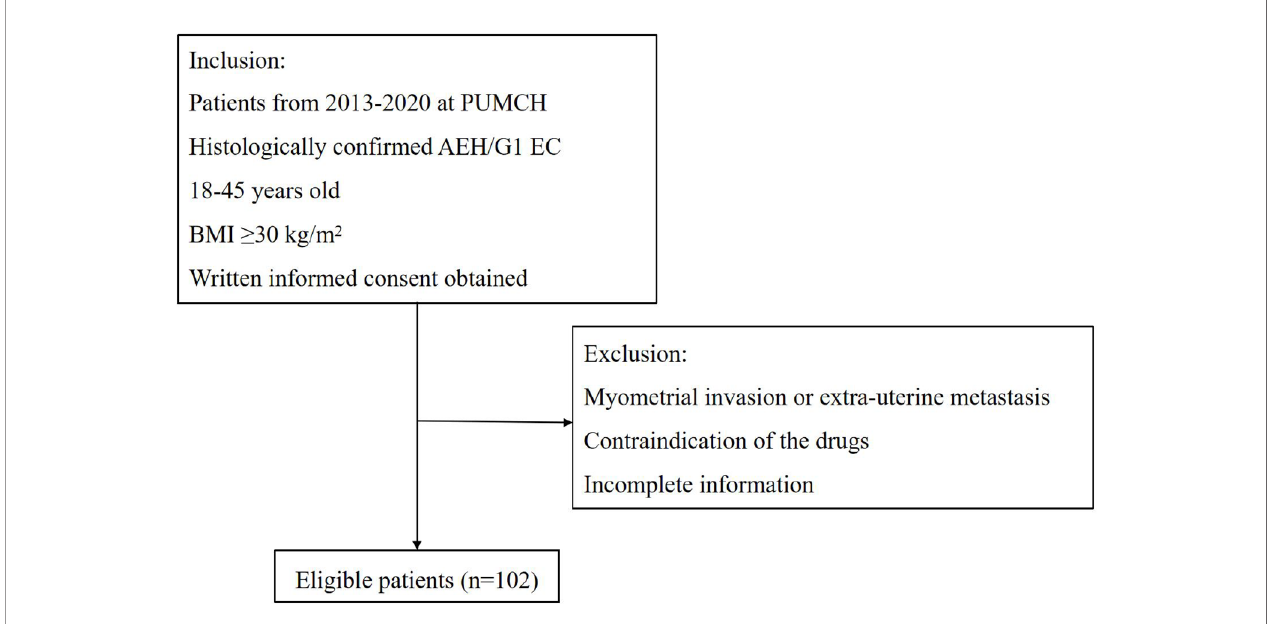
FIGURE 1 | The fl owchart of patients ’